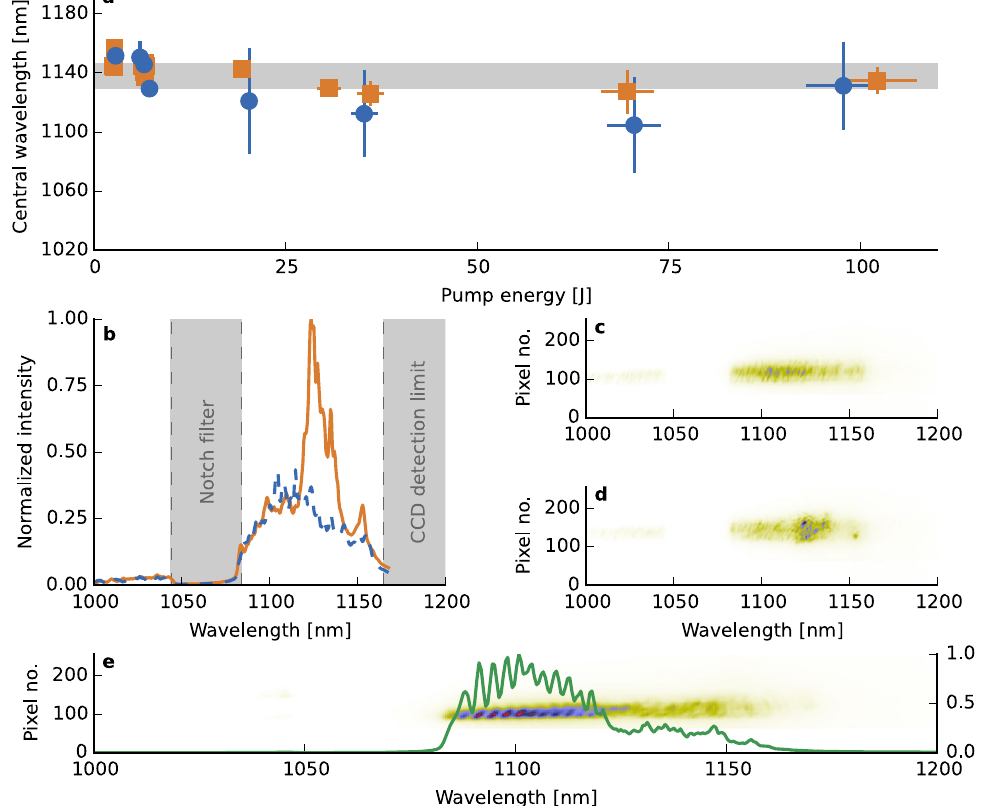
Figure 3. Spectra analysis. ( a ) Comparison between the central wavelengths of (blue circle) N-RS spectra and (orange square) S-RS + N-RS spectra. The error bars in the vertical axis represent the measured bandwidth at FWHM. The grey area illustrates the initial seed features. ( b ) Examples of spectra for a nominal pump energy of 35 J: N-RS spectrum shown in dashed (blue) line, S-RS + N-RS spectrum presented in solid (orange) line. ( c ) and ( d ) spectral images of Raman amplification without and with seed, respectively. The spectra correspond to the ones presented in ( b ). ( e ) example of a spectrum showing strong modulations, obtained for a 6 J pump beam only.